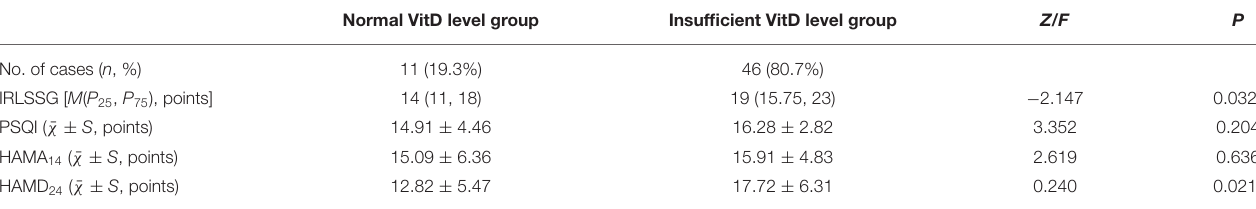
TABLE 3 | Comparison of clinical data between the normal VitD level group and the insufficient VitD level group.